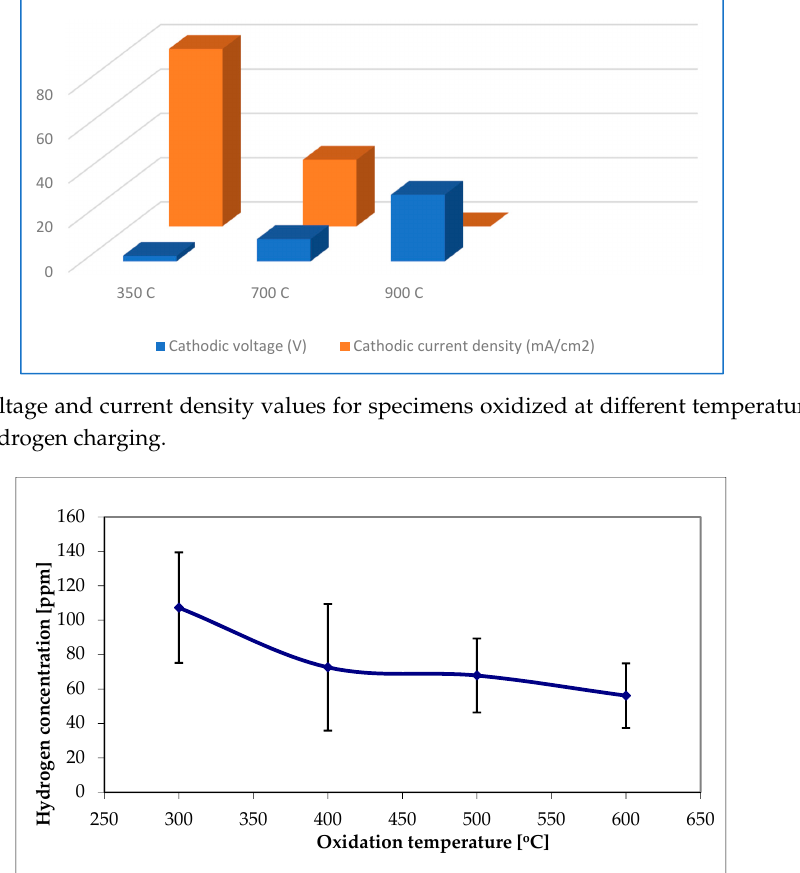
Figure 6. Effect of oxidation temperature on a hydrogen content. The means and standard deviations based on six independent measurements are shown.